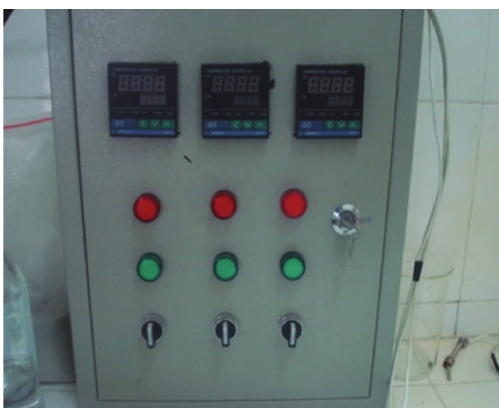
Figure 6: Control cabinet.